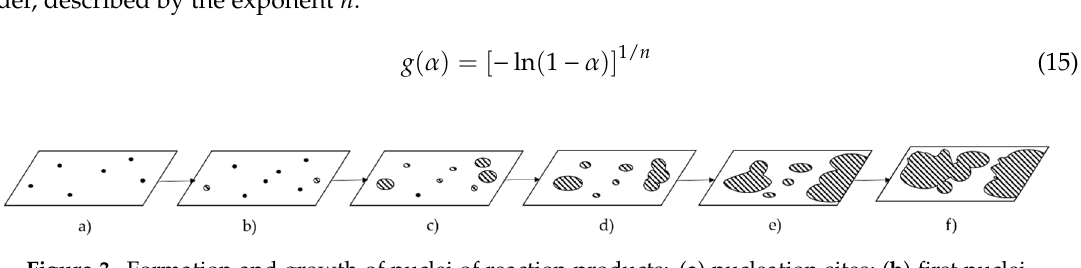
Figure 2. Order-based reaction models: ( a ) f ( α )plots; ( b ) g ( α ) plots.